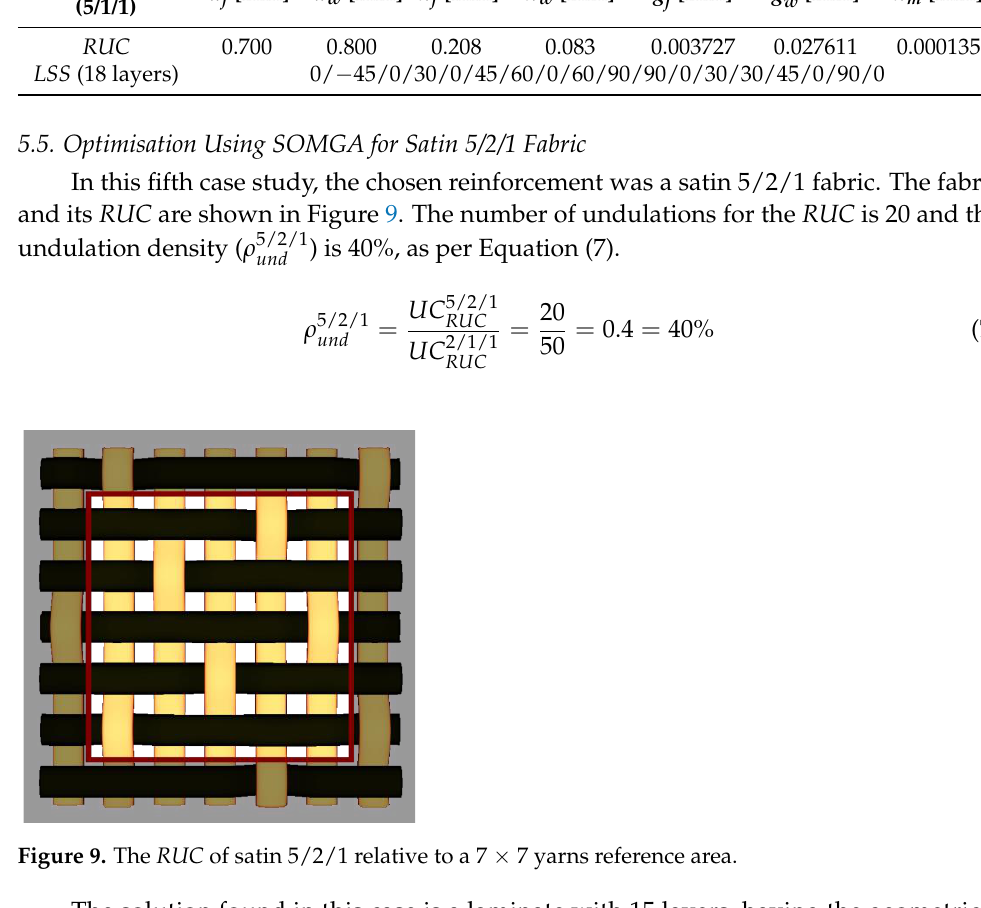
Table 8. The best solution found with satin 5/2/1 fabric as reinforcement.